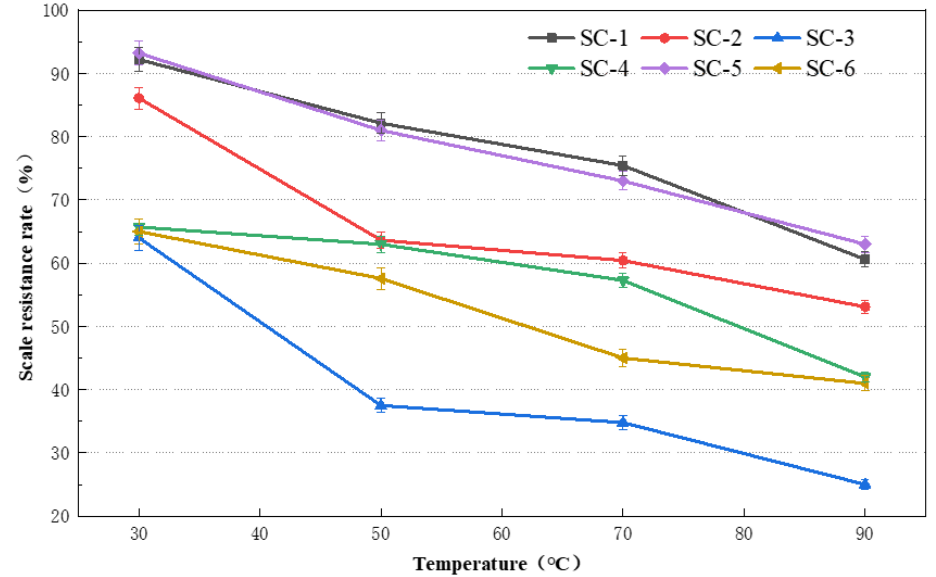
Figure 2. Effect of scale inhibitor on calcium sulfate at different temperature at pH of 7.